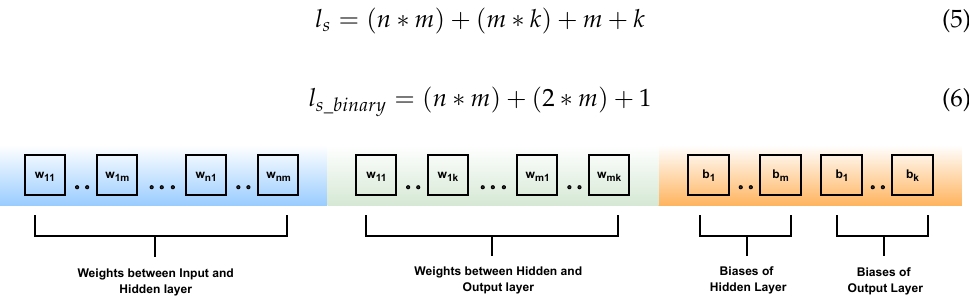
Figure 5. A representation of solution vectors